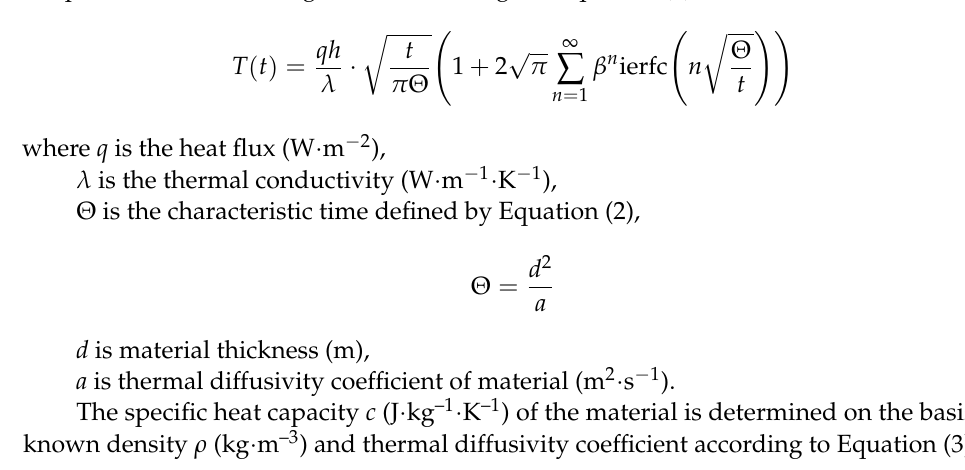
Figure 5. Scheme of EDPS method apparatus [32].